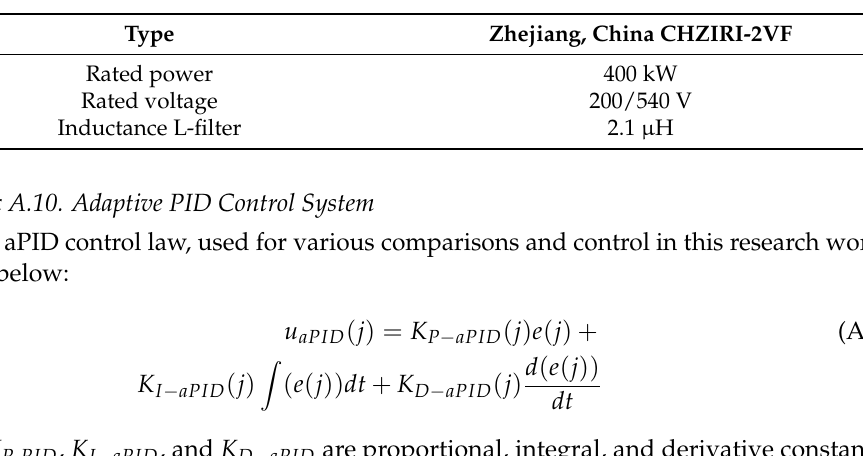
Table A9 below gives the parameters of interlinking inverter used in this research work: Table A9. Parameters of Interlinking